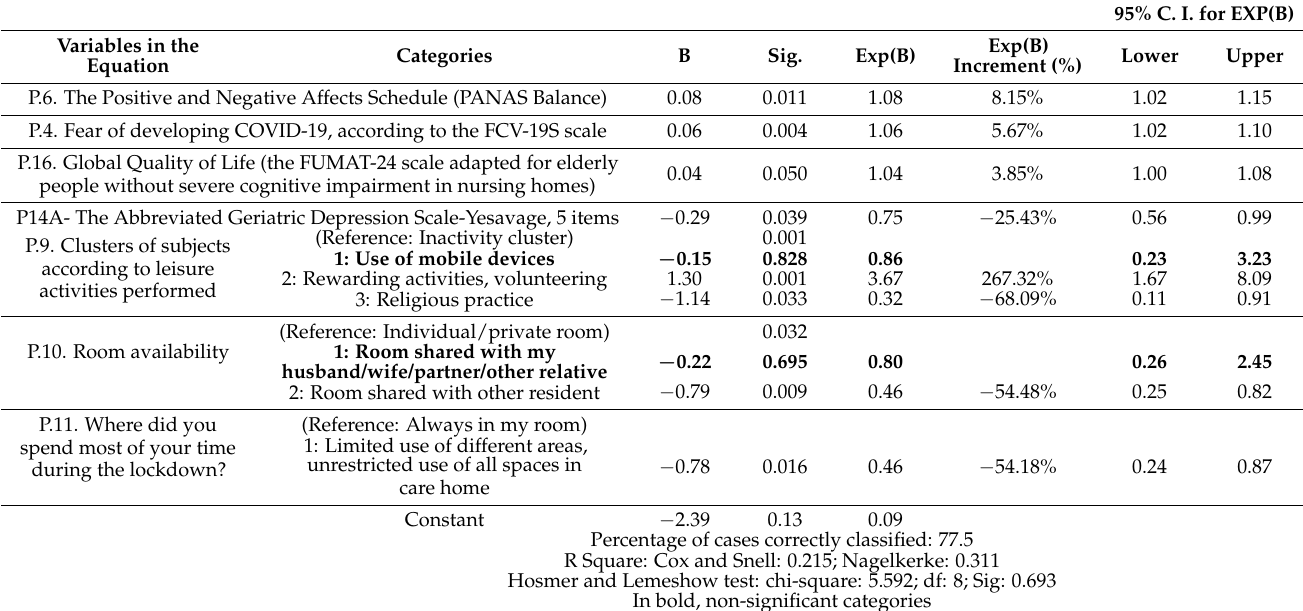
Table 2. Logistic regression model for residential assessment cluster 1: medium-high rating for all aspects of the residential environment.